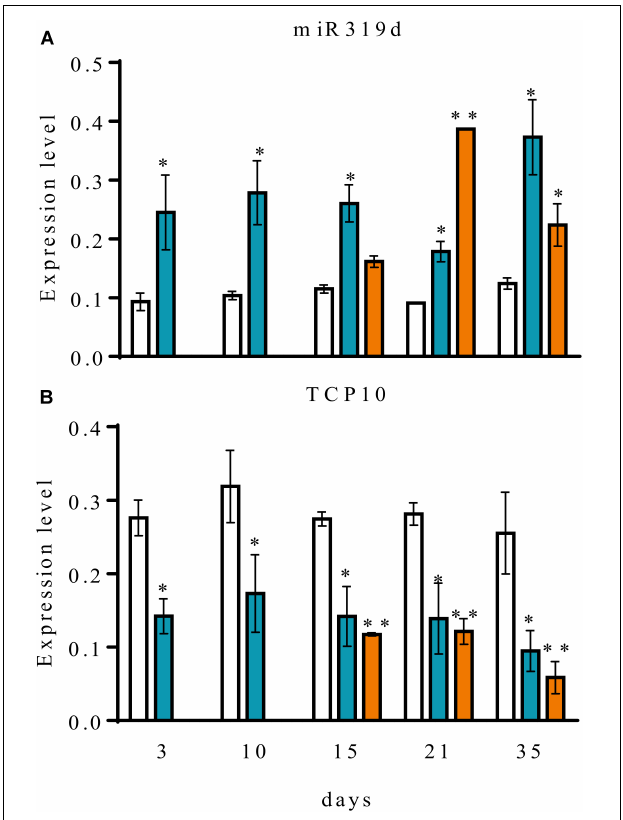
FIGURE 3 | Expression analysis of common bean miR319d and TCP10 target gene in roots (blue histograms) and nodules (orange histograms) of R. tropici CIAT899-inoculated plants and root (white histograms) of fertilized (non-inoculated) plants. Expression level of mature miR319d (A) and its target gene TCP10 (B) were determined by qRT-PCR in inoculated roots or nodules harvested at the indicated time points, corresponding to days post inoculation for inoculated plants or days after planting for fertilized plants. Expression level refers to gene expression, based on Ct value, normalized with the expression of the housekeeping U6 for miR319d and UBC9 , HSP and MDH for TCP10 gene. Values represent means ± SD from three biological replicates and two technical replicates each. The Mann-Whitney null hypothesis statistical test is relative to data from fertilized plants from the same harvest ( ∗ and ∗∗ represent a p- value < 0.05 and p- value < 0.01, respectively).